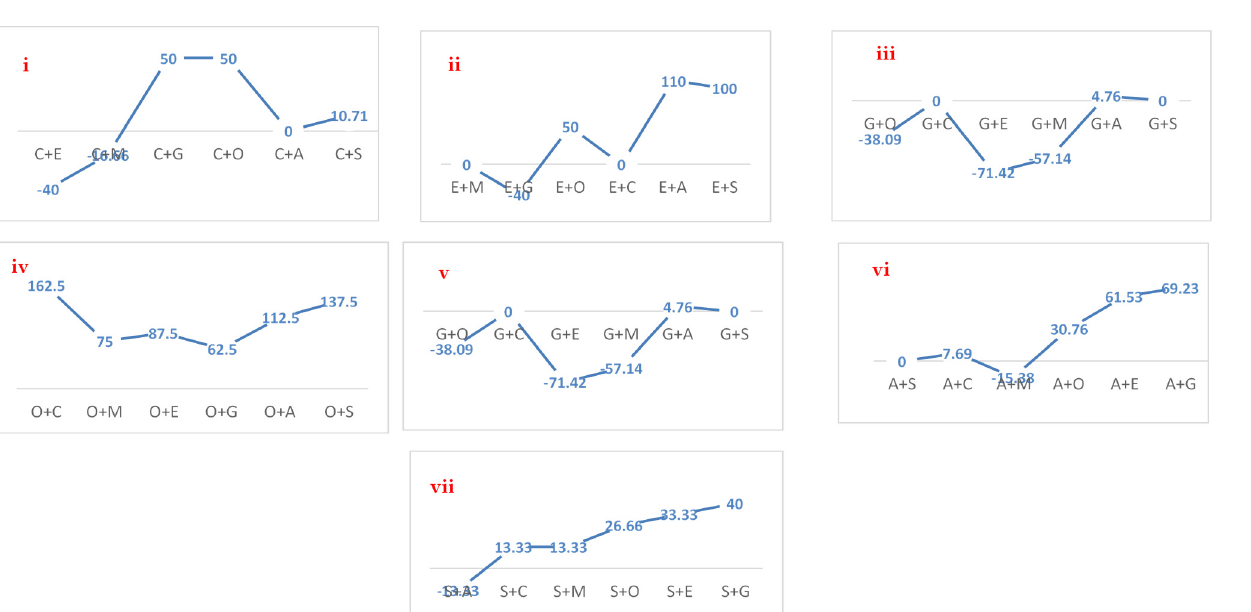
Table 5. Synergy testing of drugs against E. coli isolates.